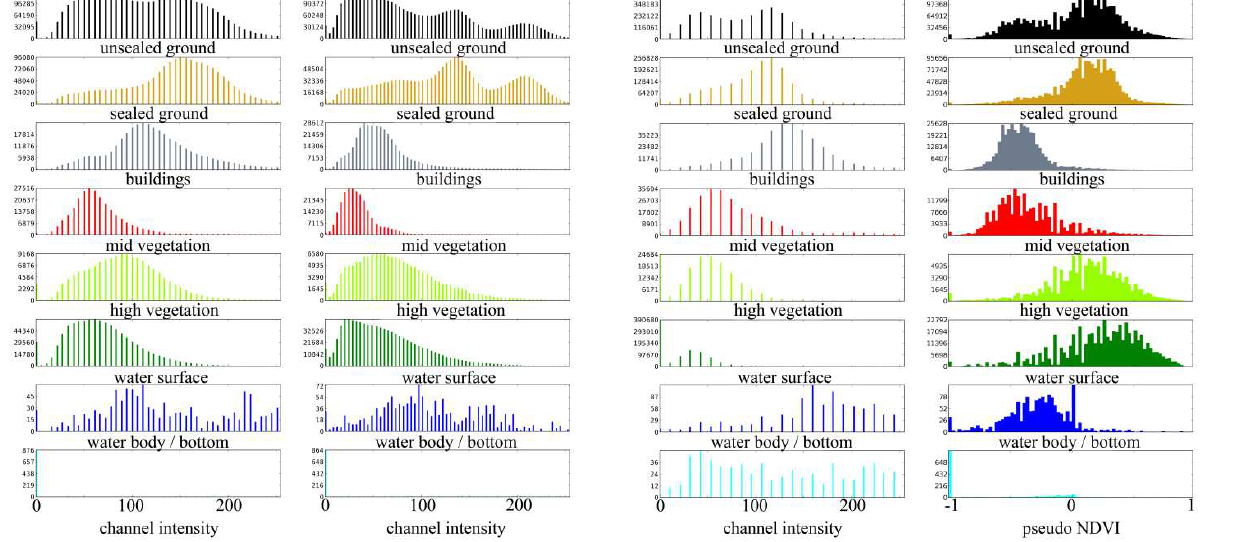
Figure 2. Class specific 8 bit scaled channel histograms for 1,550 nm and 1,064 nm wavelength laser signals (counts/bin)